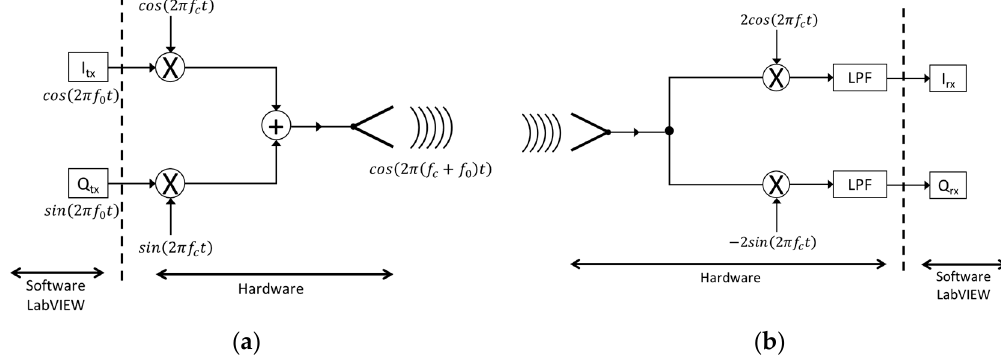
Figure 7. SDR NI USRP 2920 transceiver: ( a ) I/Q NI USRP 2920 Modulator; ( b ) I/Q NI USRP 2920 demodulator. LPF, Low-pass filter.